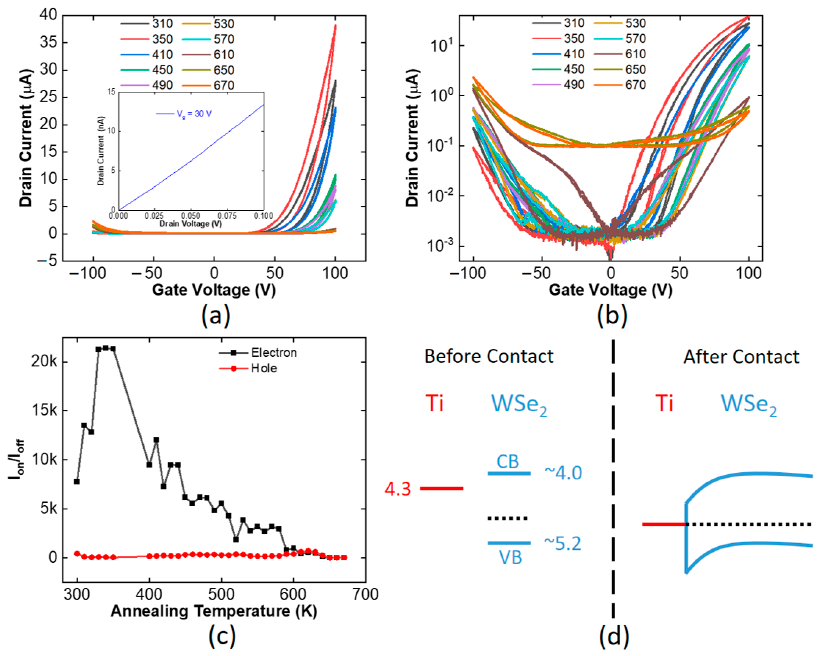
Figure 2. ( a ) Transfer characteristics curve of the WSe 2 device measured at 300 K after annealing at different temperatures on a linear scale (legend shows the annealing temperature in Kelvin, and inset represents the I d – V d curve of the device). ( b ) Transfer characteristics curve of the WSe 2 device measured at 300 K after annealing at different temperatures on a semi-logarithmic scale (legend shows the annealing temperature in Kelvin). ( c ) The ratio of on current to the off current of the device as a function of annealing temperatures. ( d ) Schematic band diagram showing Ti and WSe 2 before and after